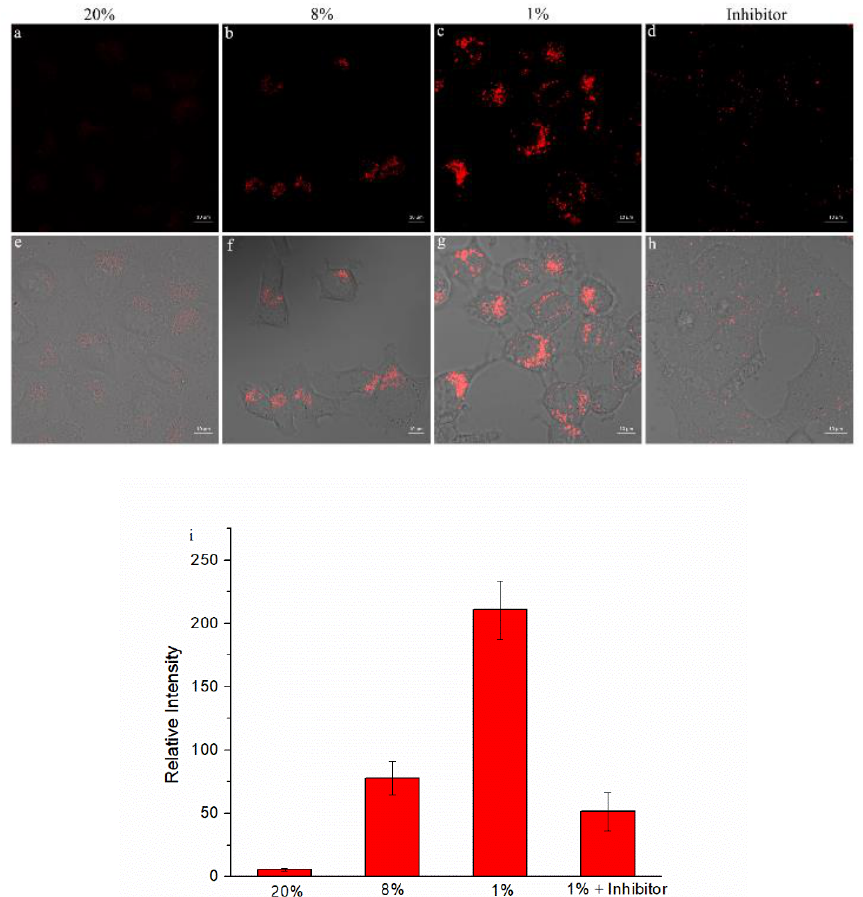
Figure 4. Confocal fluorescence imaging of HepG2 cells incubated with Py-SiRh-NTR (2 μM) under different oxygen concentration conditions. ( a – d ) The near-IR channel fluorescence image (λex = 633 nm). ( e – h ) The merged image of near-IR channel fluorescence image and bright filed imaging. ( i ) Average fluorescence intensity from images of ( a – d ).